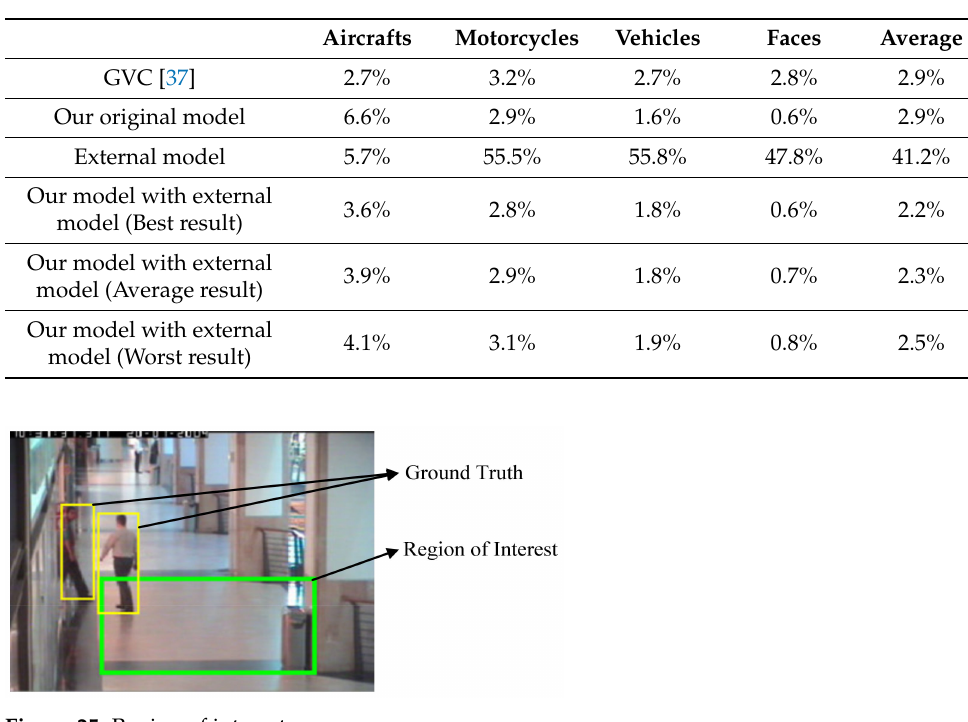
Table 7. Enhanced result (error rate) of combination with the external aircraft model in Caltech.